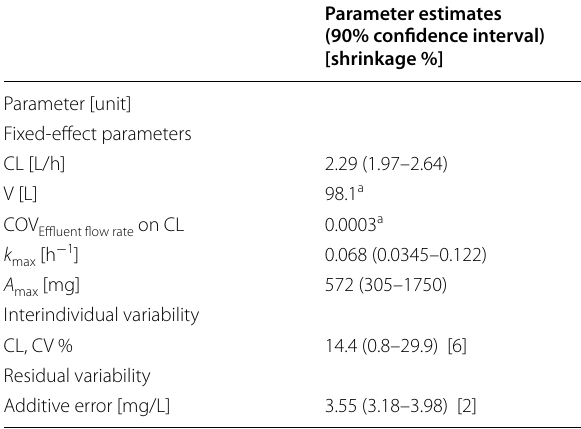
Table 2 Parameter estimates for the final pharmacokinetic model